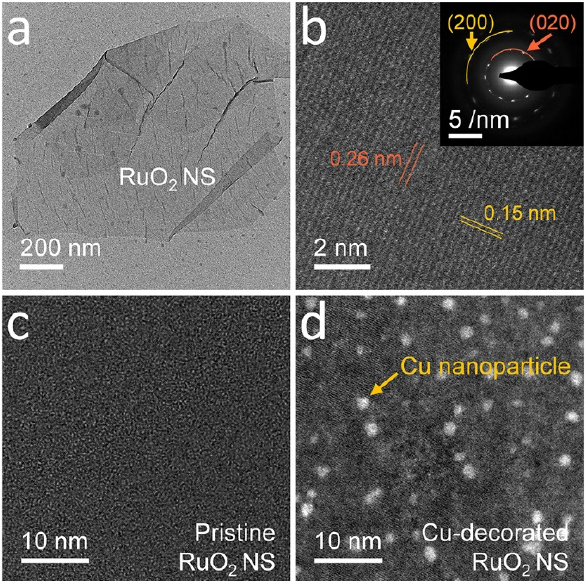
Figure 1. Exfoliated RuO 2 nanosheet and metal nanoparticle decoration. ( a ) Transmission electron microscopy (TEM) and ( b ) scanning transmission electron microscopy (STEM) images of an exfoliated RuO 2 nanosheet. The inset image of ( b ) illustrates an electron diffraction (ED) pattern of the nanosheet. ( c , d ) Low-magnitude TEM images of a RuO 2 nanosheet ( c ) before, and ( d ) after, the surface decoration with Cu nanoparticles.